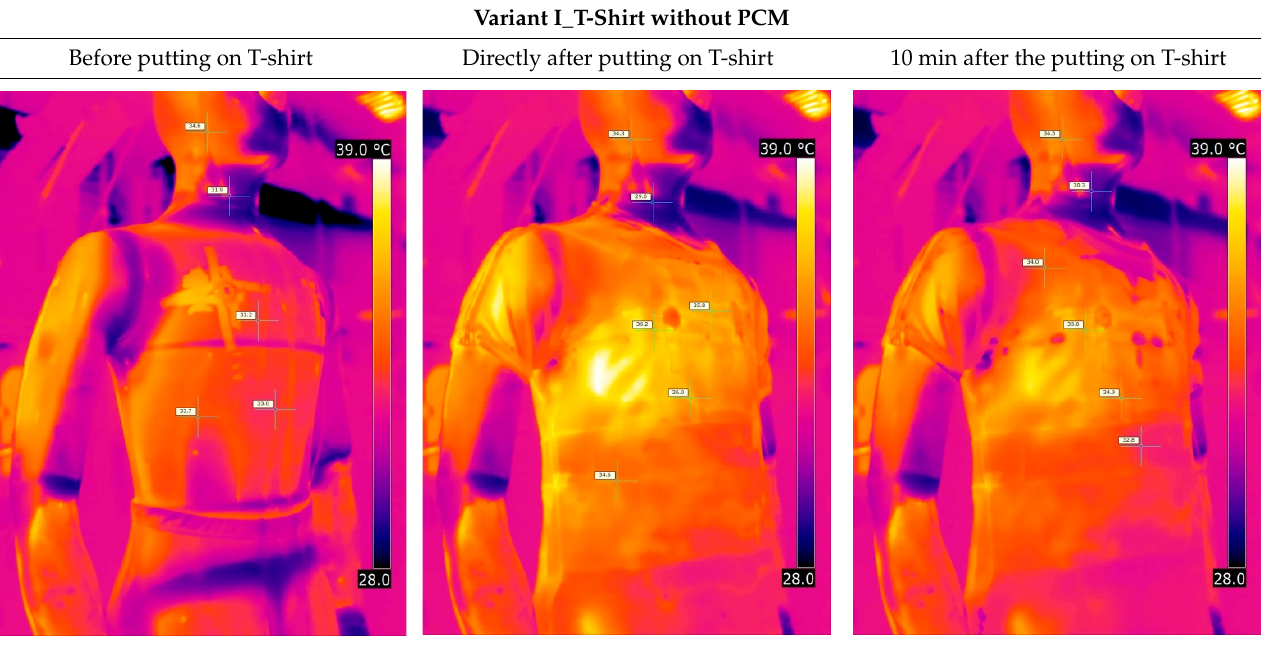
Table 2. Pictures from thermal imaging cameras for variants I and